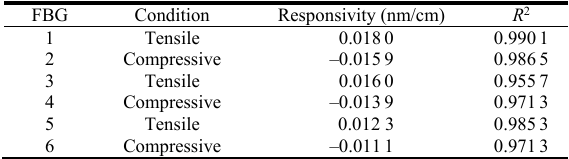
Table 2 Responsivity of each strain sensitive FBG to strain variation.